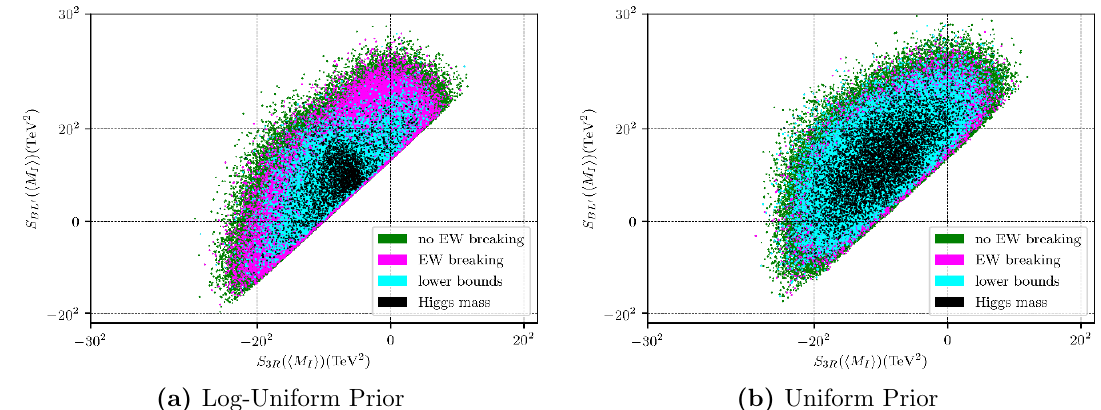
Figure 16. Plots of the 100 million initial data points for the RG analysis evaluated at M I . In (a) we used our usual log-uniform prior distribution, while in (b) we used a uniform prior. The green points lead to appropriate breaking of the B (cid:0) L symmetry. The purple points also break the EW symmetry with the correct vector boson masses. The cyan points correspond to the points that, in addition to appropriate B (cid:0) L and EW breaking, also satisfy all lower bounds on the sparticle masses. Finally, as a subset of these initial points, there are the valid black points which lead to the experimentally measured value of the Higgs boson mass.